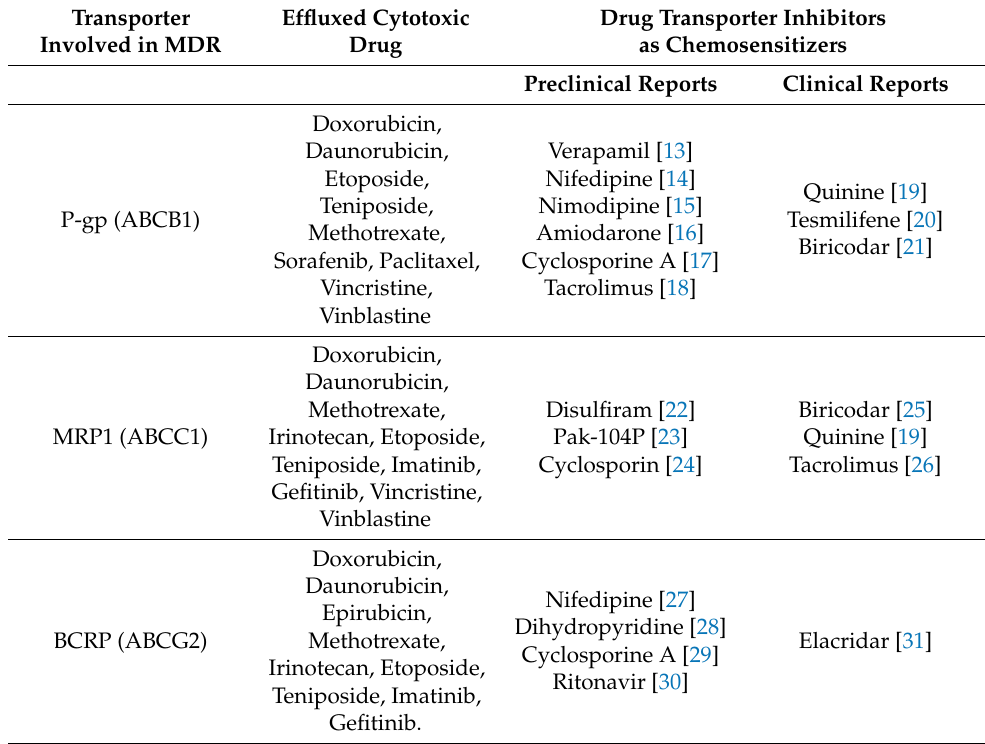
Table 1. Involvement of efflux pumps in MDR and their inhibitors as